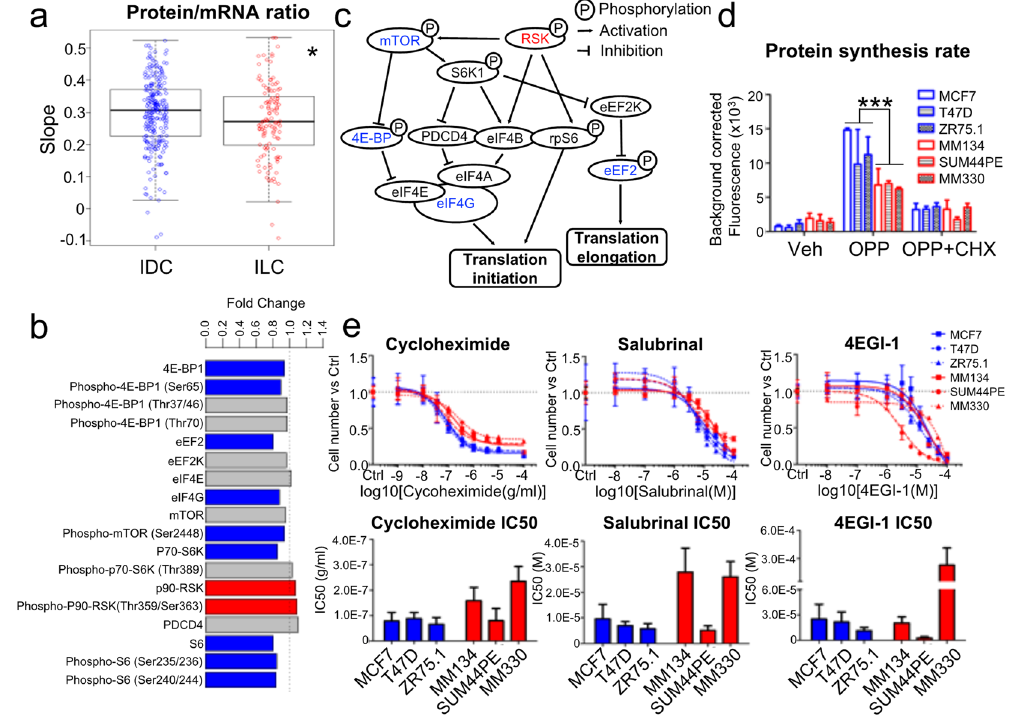
Figure 3. LumA ILC has lower protein translation efficiency than LumA IDC. ( a ) Protein/mRNA ratio in LumA ILC (n = 115) and LumA IDC (n = 246). Mann-Whitney U test, * p < 0.05. ( b ) Protein levels of translation regulators in LumA ILC vs LumA IDC. Protein expression data were from TCGA RPPA. Limma was used to compare the protein expression of LumA ILC to LumA IDC with CPE correction. Significant DE proteins (Benjamini-Hochberg method adjusted p-value < 0.05) were marked in red (up-regulated in LumA ILC) or blue (down-regulated in LumA ILC). ( c ) Regulation network of protein translation regulators in Fig. 2b. Modified from 65 . ( d ) Protein synthesis rate of ILC and IDC cell lines. O-propargyl-puromycin (OPP) labeled the newly synthesized proteins. Fluorescence representing the amount of OPP indicated the protein synthesis rate of cells. Cells without OPP labeling or pre-treated with cycloheximide (CHX) to inhibit protein synthesis served as negative controls. Representative data of two independent experiments were presented. Data are mean ± s.d. of 3 replicates. Two-way ANOVA, *** p < 0.001. ( e ) Dose response and IC50 of translation inhibitors in ILC and IDC cell lines. 4EGI-1 to inhibit the binding of eIF4E and eIF4G, cycloheximide to inhibit the tRNA translocation, salubrinal to inhibit eIF-2 α were used. Representative data of at least two independent experiments were presented. Data in dose response curves are mean ± s.d. of 6 replicates. Data in bar graphs of IC50 are mean + upper limit of 95% confidence intervals. Two-tailed t-test was performed to compare the IC50s between ILC and IDC cell lines. The p-values for cycloheximide, salubrinal and 4EGI-1 are 0.15, 0.17 and 0.42,